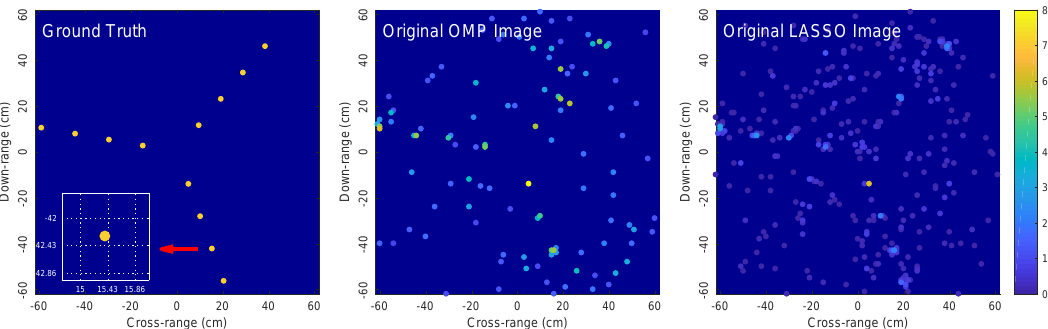
Figure 2. Problems with imaging off-grid scatterers: simulations with OMP and LASSO for a rotating target with 12 off-grid scatterers. The dictionary Φ is constructed from a regularly-spaced grid with G ∈ {− 25 λ : λ /2 : 25 λ } and y ∈ {− 25 λ : λ /2 : 25 λ } . LASSO is halted when it achieves the same x G , n G , n error residual as OMP.